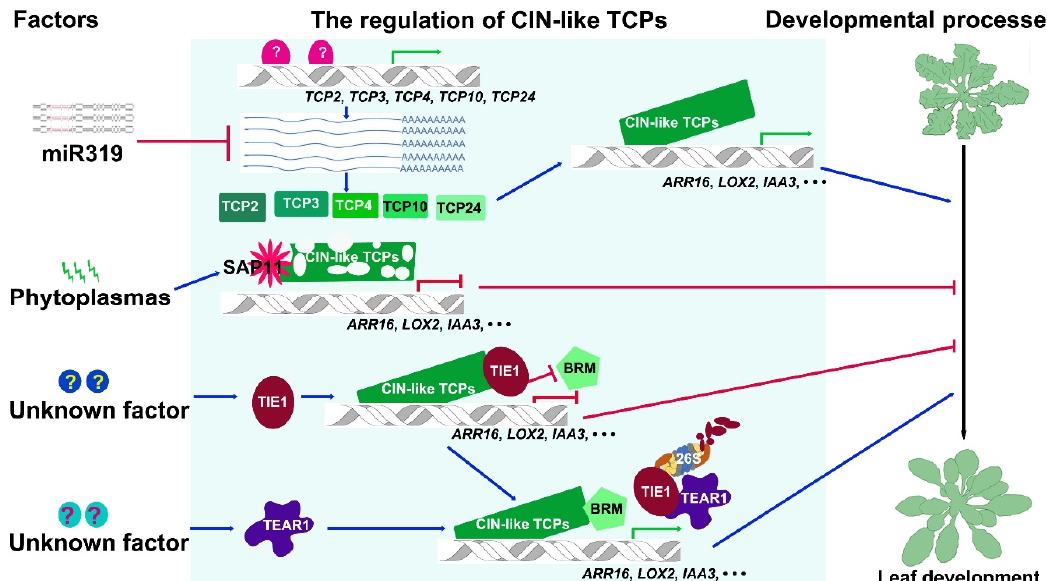
Figure 3. An overview of the regulation mechanisms of CIN-like TCP transcription factors during leaf development. The external stimuli and internal factors are summarized at the left column. The schematic diagram includes the regulation mechanisms of CIN-like TCPs at the transcriptional level, at the post-transcriptional level, and at the protein level. The arrows directly pointing on the double helix symbols indicate transcriptional regulations. The arrows pointing to the proteins indicate the regulations of protein stabilities or antagonistic functions. The proteins related with the “26S” symbols indicate protein degradation through the ubiquitin-26S proteasome pathway. The blue arrows represent the positive regulation, and the red arrows with dash-headed ends indicate the negative regulation. The green arrows and red dash-headed ends at the double-helix icons indicates the activation and repression of gene expression, respectively. All the unknown factors are indicated with question marks. R:FR, red light: far red light ratio; YUCs, YUCCAs; LOX2, LIPOXYGENASE 2; SAP11, SECRETED AY-WB PROTEIN 11; ARR16, ARABIDOPSIS RESPONSE REGULATOR 16; IAA3, INDOLE-3-ACETIC ACID INDUCIBLE 3; BRM, BRAHMA; TIE1, TCP INTERACTOR CONTAINING EAR MOTIF PROTEIN 1; TEAR1, TIE1-ASSOCIATED RING-TYPE E3 LIGASE 1.